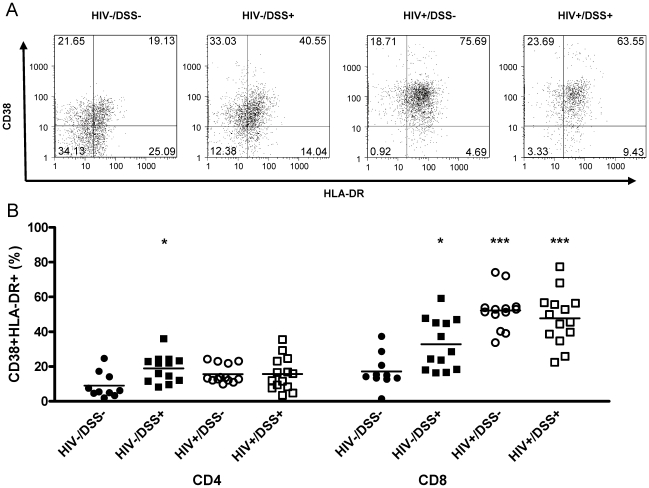
HIV-infected humanized mice had high levels of CD8+ T-cell activation.Control (black symbols) or HIV-infected mice (white symbols) received normal drinking water (circles) or 0.75% DSS (squares) for 2 weeks. (A) Activation levels in the spleen were determined by flow cytometry of human HLA-DR and CD38 staining of CD45+CD8+ (one representative animal per group) and CD45+CD4+ splenocytes. (B) DSS treatment alone slightly increased activation levels of CD4+ (*, P = 0.004) and CD8+ cells (*, P = 0.007), over those in uninfected, untreated control mice. HIV infection drastically increased CD8+ cell activation in animals that received normal (***, P<0.0001) or DSS (***, P<0.0001) water (n = 50, pooled data from two independent experiments).